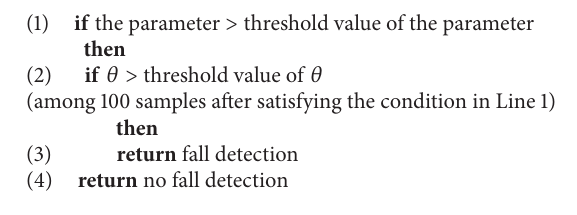
Algorithm 1: Simple threshold algorithm using double parameters for fall